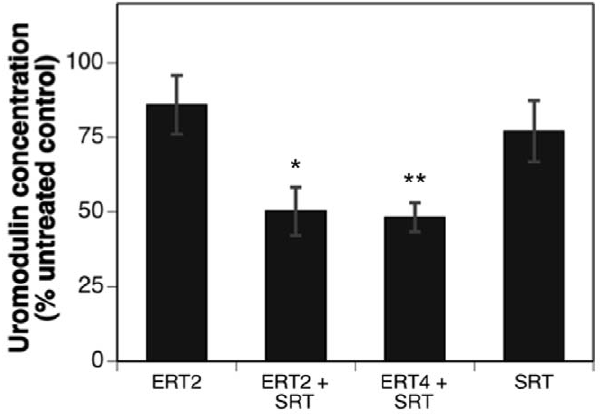
Figure 5. Combined enzyme-replacement therapy and sub- strate reduction therapy is most effective at reducing uromo- dulin levels in the urine of Fabry-Rag mouse. Urine was collected from 10-month old Fabry-Rag mice. Mice receiving no treatment were used to standardize urine volume and uromodulin levels for those treated with ERT every two months (ERT2), ERT every two month- s + eliglustat tartrate (ERT2 + SRT), ERT every four months + eliglustat tartrate (ERT4 + SRT) and eliglustat tartrate alone (SRT). Relative urine uromodulin levels from the Fabry-Rag mice were determined using a sandwich ELISA. Data are presented as % of uromodulin concentration relative to an age-matched untreated control Fabry-Rag mouse. Data are shown as mean 6 SEM (n=10 mice/time point). Statistical comparisons are to the ERT2 treatment group and were determined using the Graphpad Prism software t test (*=p , 0.05; **=p , 0.01; ***=p , 0.001).